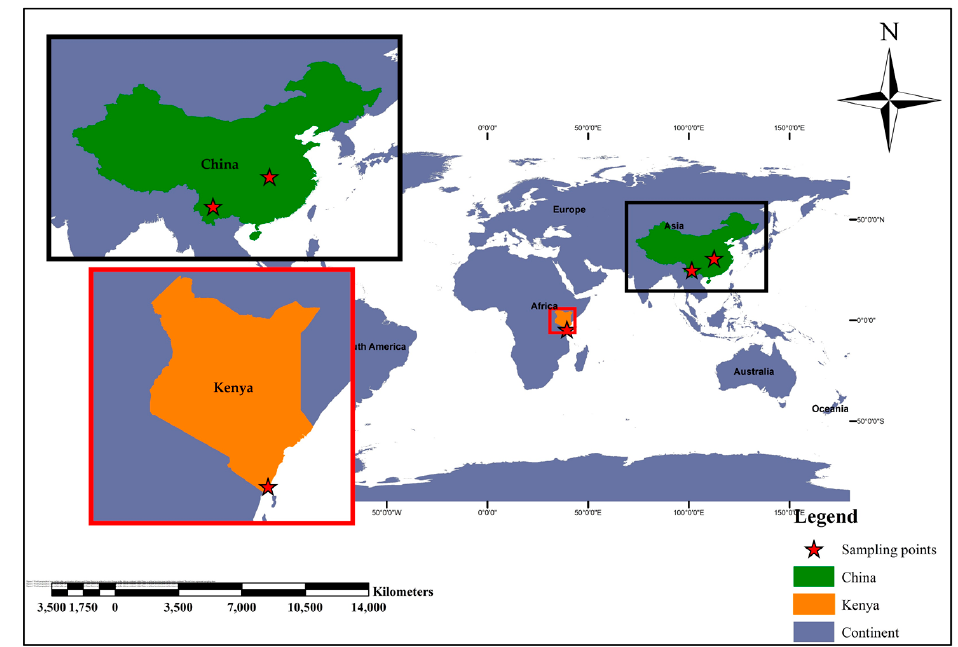
Figure 1. World geographical map outlining the geo-location of Kenya and China. Kenya is outlined in orange in the African continent while China is outlined in green in the Asian continent. The red stars represent sampling sites.